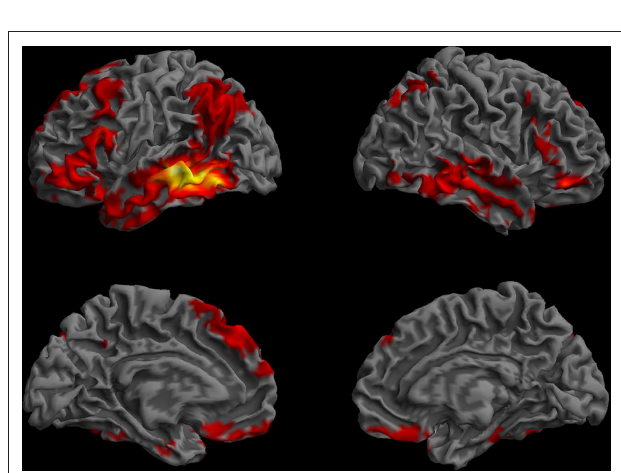
Figure 5 | Functional connectivity profile of the left posterior middle temporal region that was previously found to be critical for the core processes supporting sentence comprehension (Dronkers et al., 2004). The regions that showed highly correlated ( p < 0.01, corrected, cluster extent > 100 mm 3 ) spontaneous activity with the left MTG seed are shown on a semi-inflated view of the cortical surface. The left and right hemispheres are shown on the left and right columns, respectively. The upper row shows the lateral surface, and the lower row, the medial surface of the cerebrum. Colors indicate t -values (dark red = lowest, yellow-white = highest, with the voxels within the ROI showing the highest